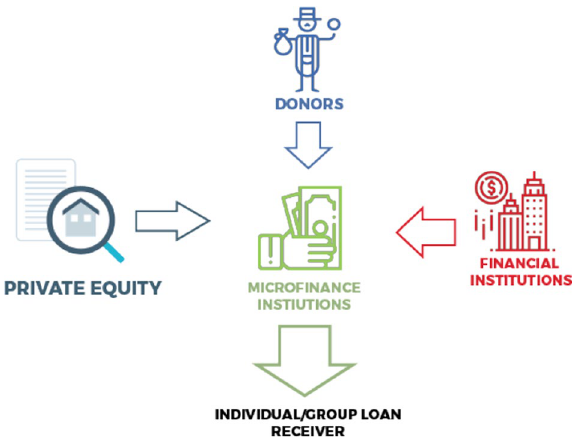
Fig. 1 Traditional credit model in